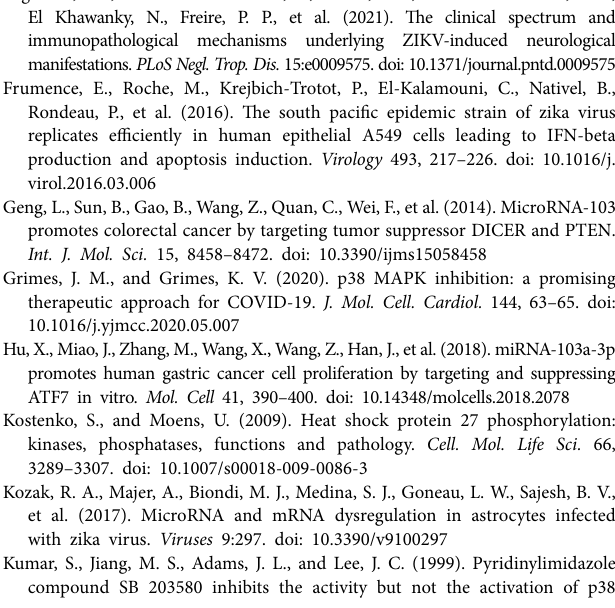
Supplementary Figure S3 | Bioinformatics analysis of miR-103a-3p target gene. Four different prediction algorithms were used to predict the putative miR- 103a-3p targets. Around 177 targets genes are overlapped in four prediction